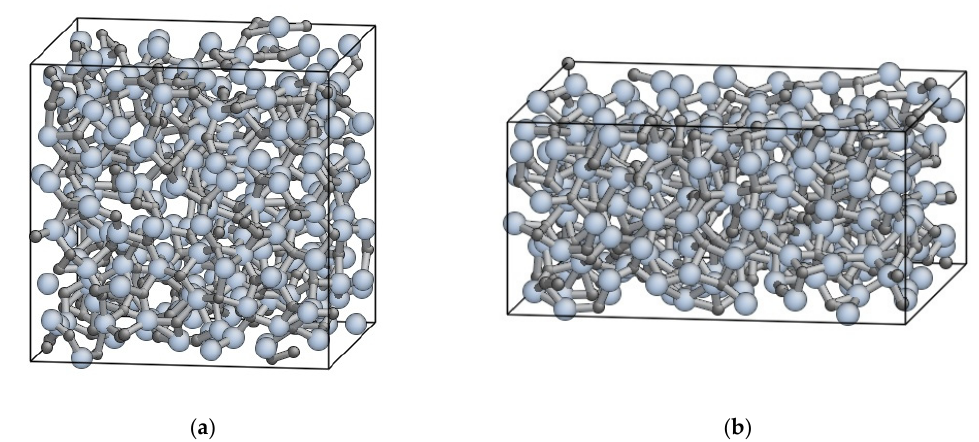
Figure 8. True stress-strain relationships under the d ε / dt -constant conditions at ( a ) T = 1000 K and ( b ) T = 1500 K. The solid curves indicate the Bezier approximation.